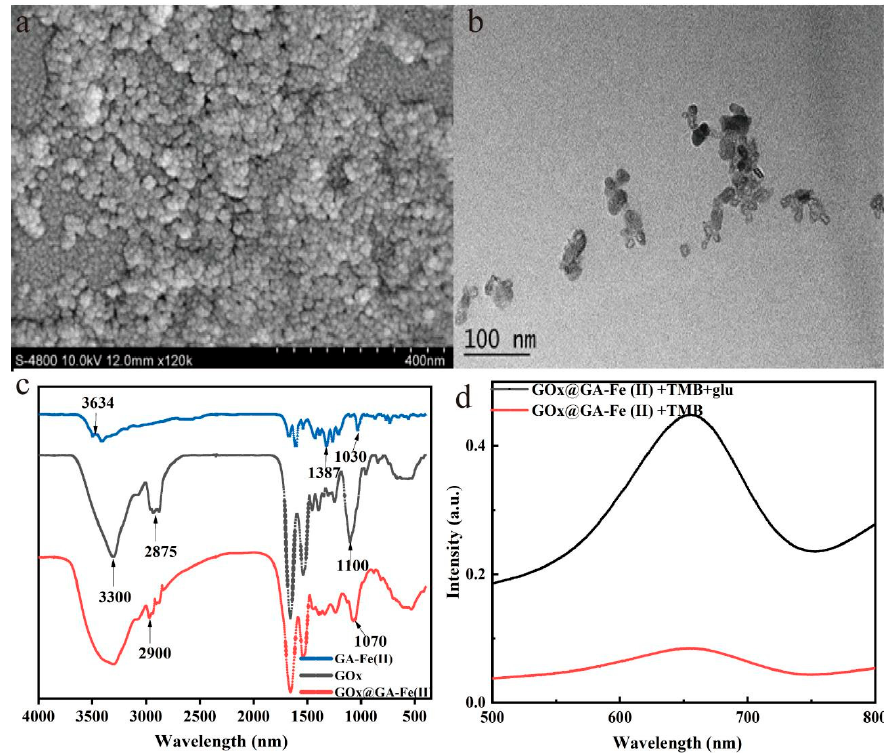
Figure 1. ( a )The SEM image of GOx@GA-Fe (ii); ( b )the transmission electron microscopy image of GOx@GA-Fe (ii); ( c ) the Fourier Transform infrared spectroscopy images of GOx@GA-Fe (ii), GOx, GA-Fe (ii); and ( d ) the characteristic reaction of GOx@GA-Fe (ii) to the substrate glucose.